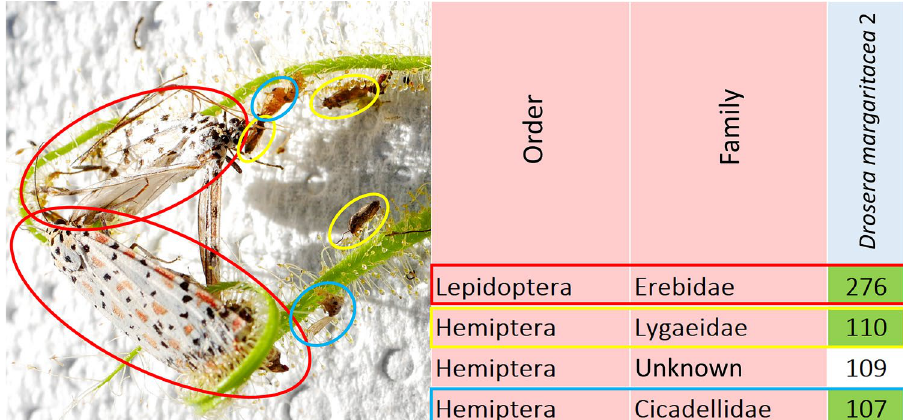
Figure 1. Example of pictorial plausibility control of DNA metabarcoding using in-situ macro photography. Left image is a macro photograph of two of the five leaves in sample 2 of Drosera margaritacea , on the right is a table of prey families detected by metabarcoding for the same sample showing their read counts in the right- bound column. Only the four prey groups with highest read counts are shown. Colours match detected prey families with visible prey items in the macro photograph (pictorial plausibility control). Picture by T.